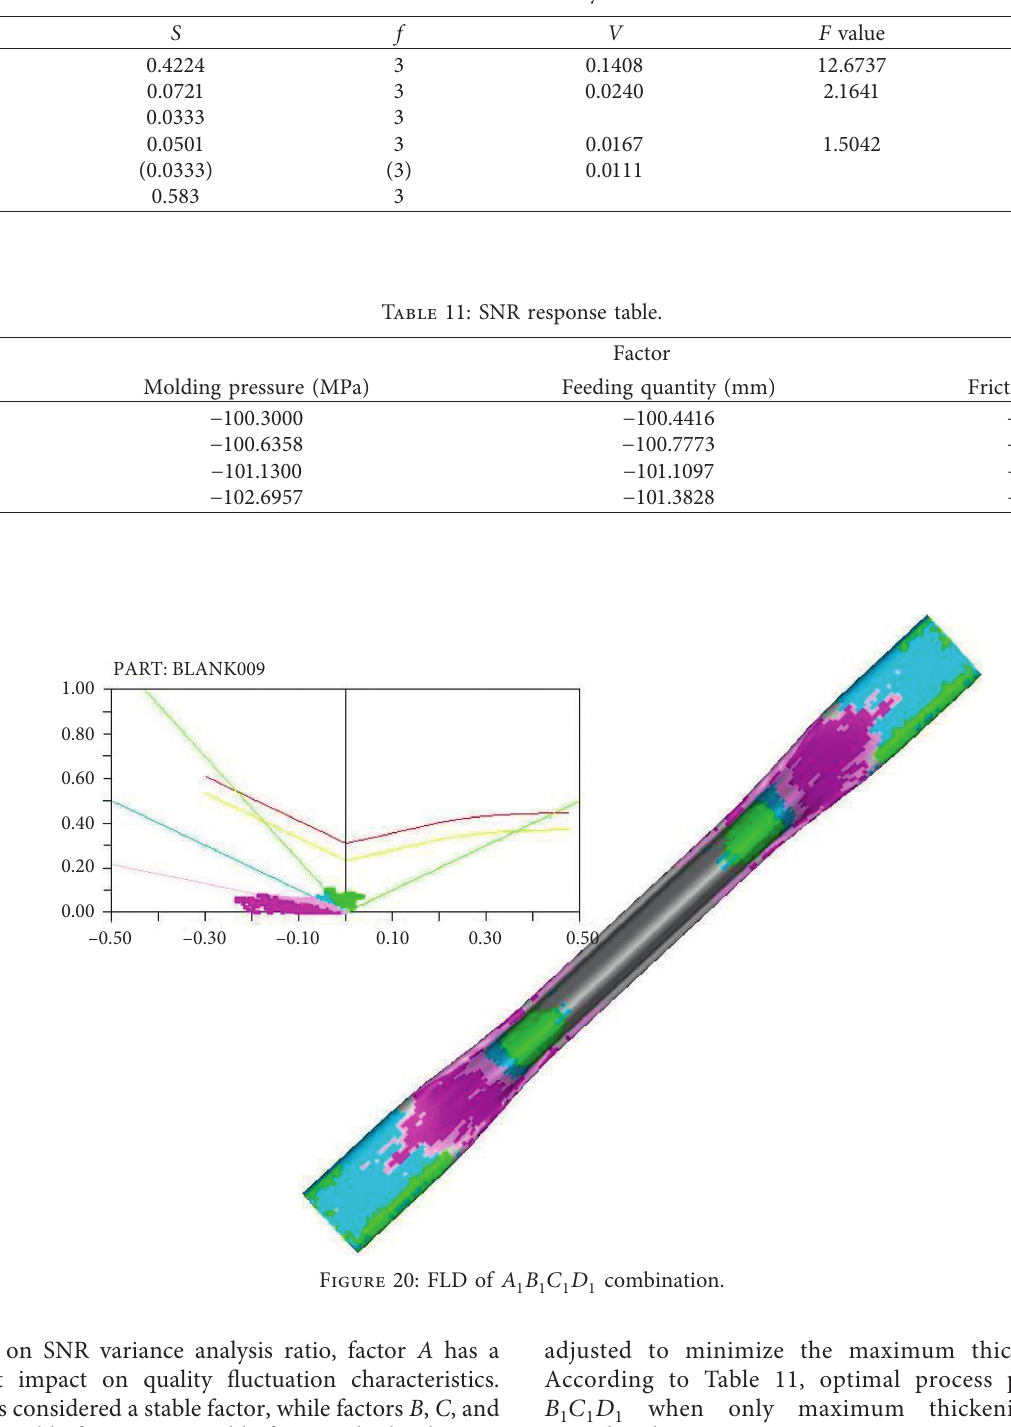
B C D combination. 1 1 1 1